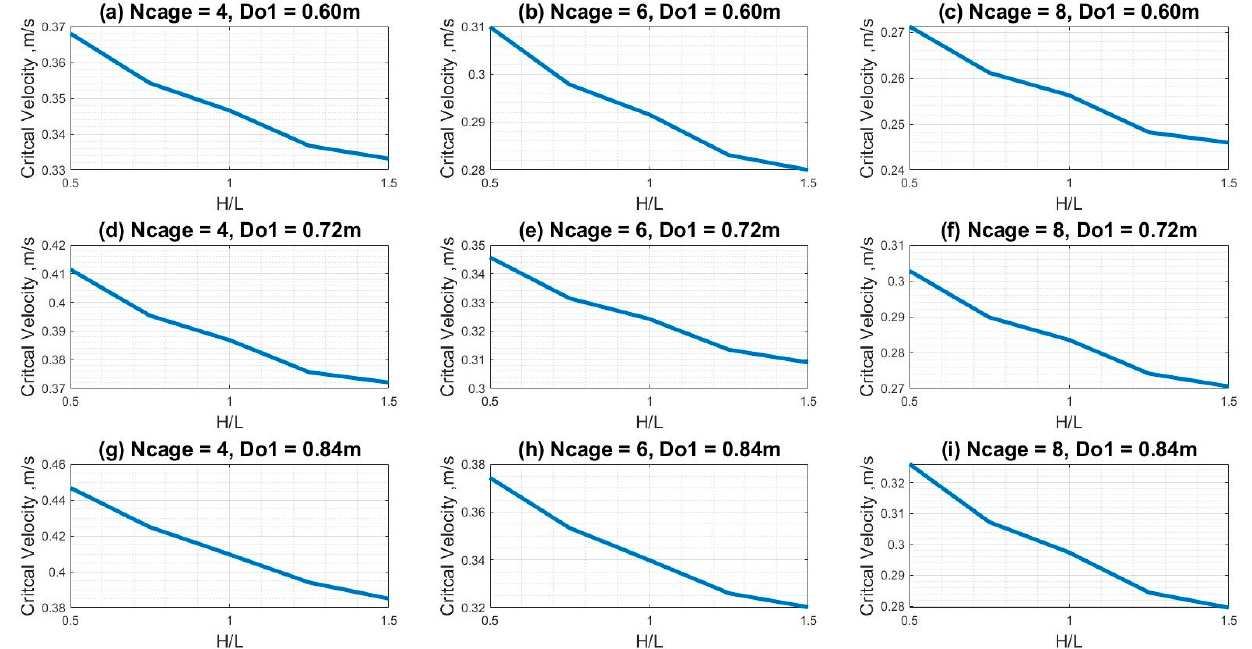
Figure 13. The critical buckling velocity for the Holding State as a function of the cage dimension ratio H/L for nine combinations of N Cage and D O 1 : ( a ) N Cage = 4, D O 1 = 0.6, ( b ) N Cage = 6, D O 1 = 0.6, ( c ) N Cage = 8, D O 1 = 0.6, ( d ) N Cage = 4, D O 1 = 0.72, ( e ) N Cage = 6, D O 1 = 0.72, ( f ) N Cage = 8, D O 1 = 0.72, ( g ) N Cage = 4, D O 1 = 0.84, ( h ) N Cage = 6, D O 1 = 0.84, ( i ) N Cage = 8, D O 1 =